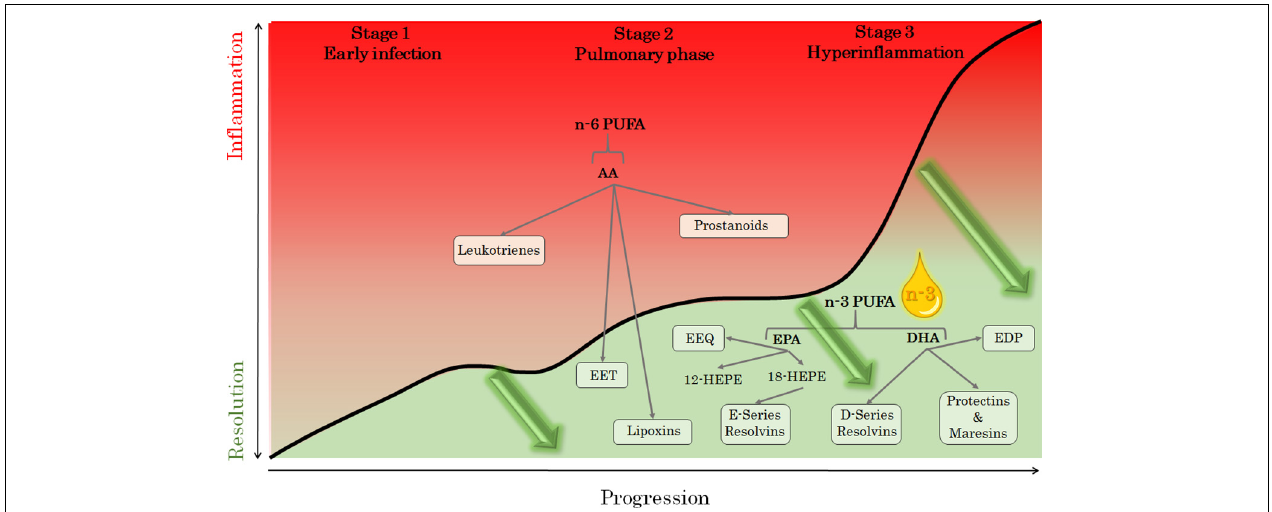
FIGURE 1 | The metabolism of the omega-6 (n-6) and omega-3 (n-3) polyunstaurated fatty acids (PUFA) arachidonic acid (AA), eicosapentaenoic acid (EPA) and docosahexaenoic acid (DHA). The pathways depicted in red indicate proinflammatory mediators during the three stages of COVID-19 severity: early infection (stage 1), pulmonary phase (stage 2), and hyperinflammation phase (stage 3); adapted from Siddiqi and Mehra (2020). Intravenous administration of n-3 PUFA is anticipated to decrease n-6 PUFA and, in particular, AA-derived proinflammatory lipid mediators, and increase specialized pro-resolving mediators (including resolvins of the E- and D-series, protectins, and maresins), as well as the monohydroxy intermediates hydroxy-EPA (HEPE) and the cytochrome P450 epoxides epoxyeicosatrienoic (EET), epoxyeicosatetraenoic (EEQ), and epoxydocosapentaenoic (EDT) acids. Mediators potentially inducing the resolution of inflammation at the different stages of COVID-19 infection (green arrows), are depicted in green.